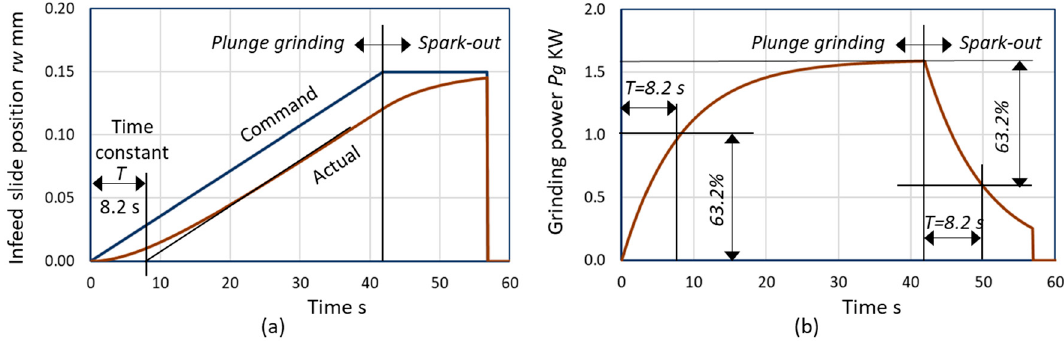
Figure 5. Simulation of plunge grinding processes (conditions: c = 1.0, dw = 177.8 mm, b = 30 mm, vs. = 45 m/s, η = 2.0, k eq = 2421 N/mm, u = 26.7 J/mm³, S = 0.3 mm, Q w ’ = 2.0 mm³/mm·s, Ip = 3.58 μ m/s, tp = 41.9 s, ts = 56.9 s). ( a ) Infeed slide position; ( b ) Grinding power.